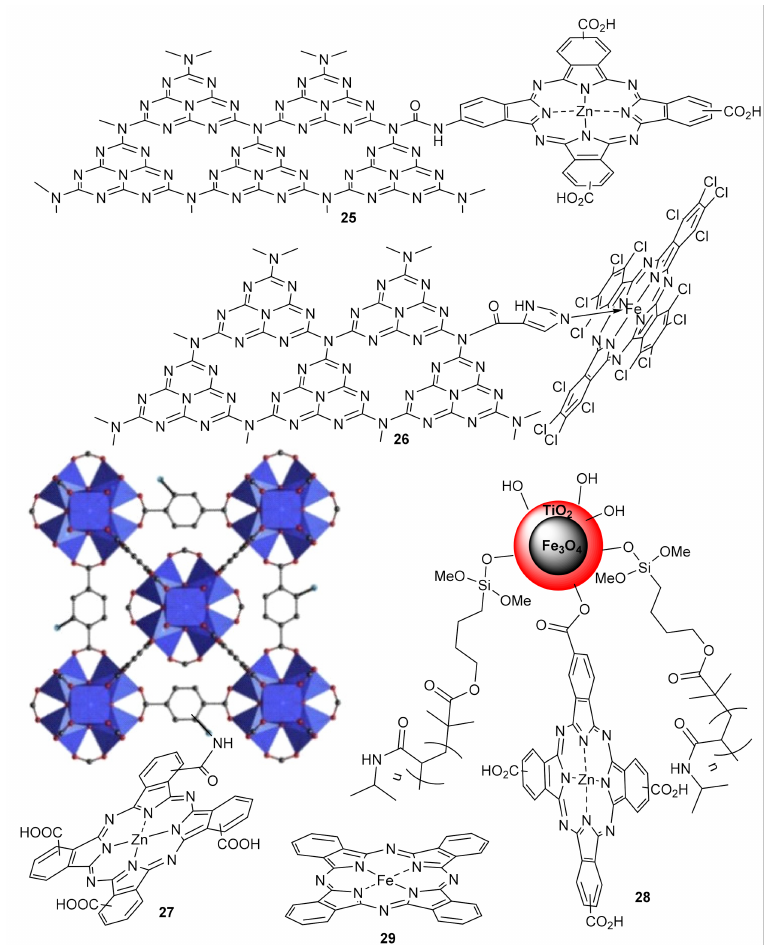
Figure 11. Immobilized phthalocyanine photocatalysts for degradation of pollutants. Structure of compound 27 was adapted with permission from ref [136]. Copyright 2017